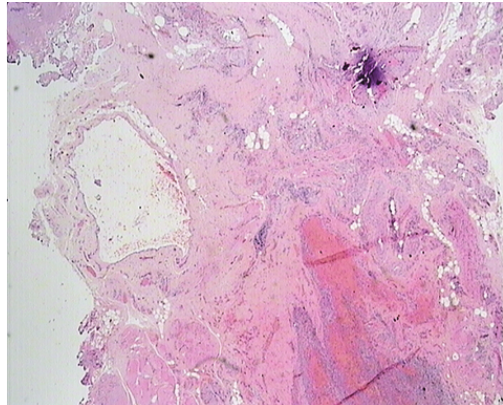
Figure 4: Endometriotic tissue (lower right) adjacent to the cystic wall (H&E ×